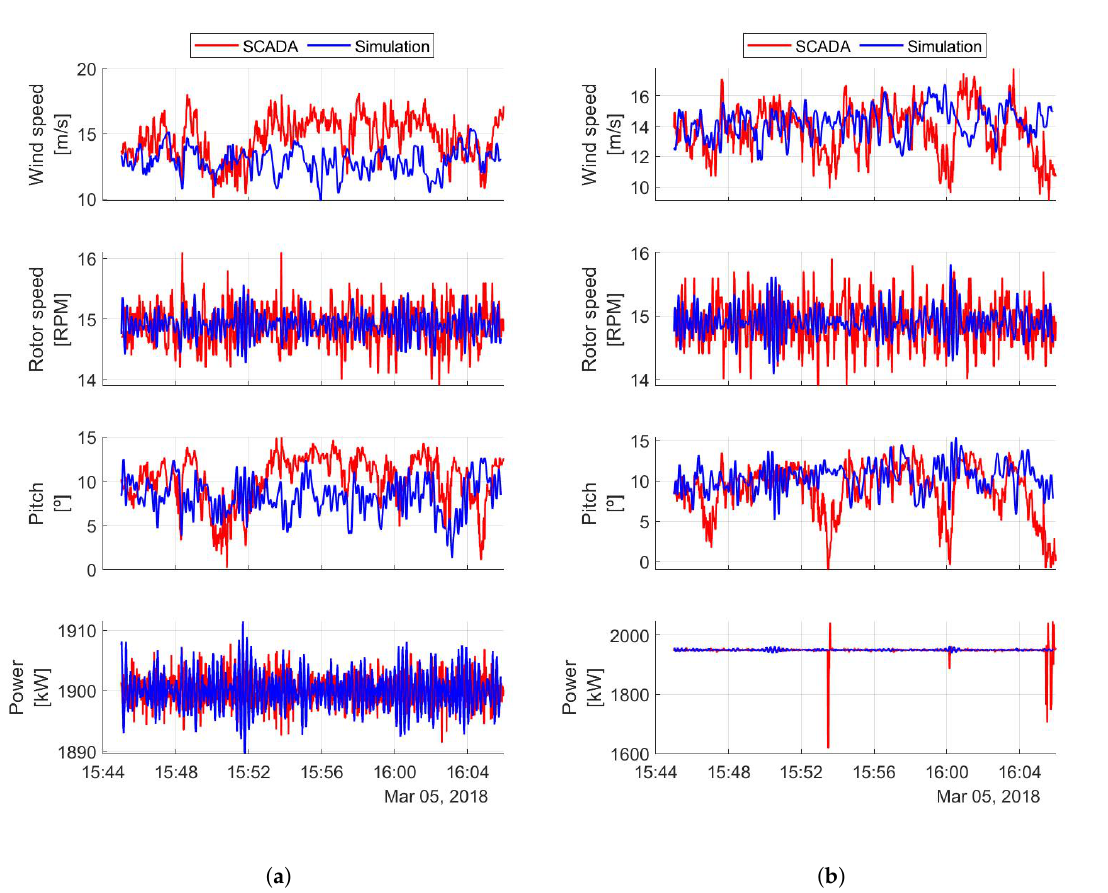
Figure 5. Simulation and Supervisory Control and Data Acquisition (SCADA) data temporal evolution of ( a ) WT1 and ( b ) WT2. Selected signals are wind speed, rotor speed, pitch angle, and electric power. Inflow condition of the simulation: Wind direction 250 ◦ (no wake interaction) and wind speed above